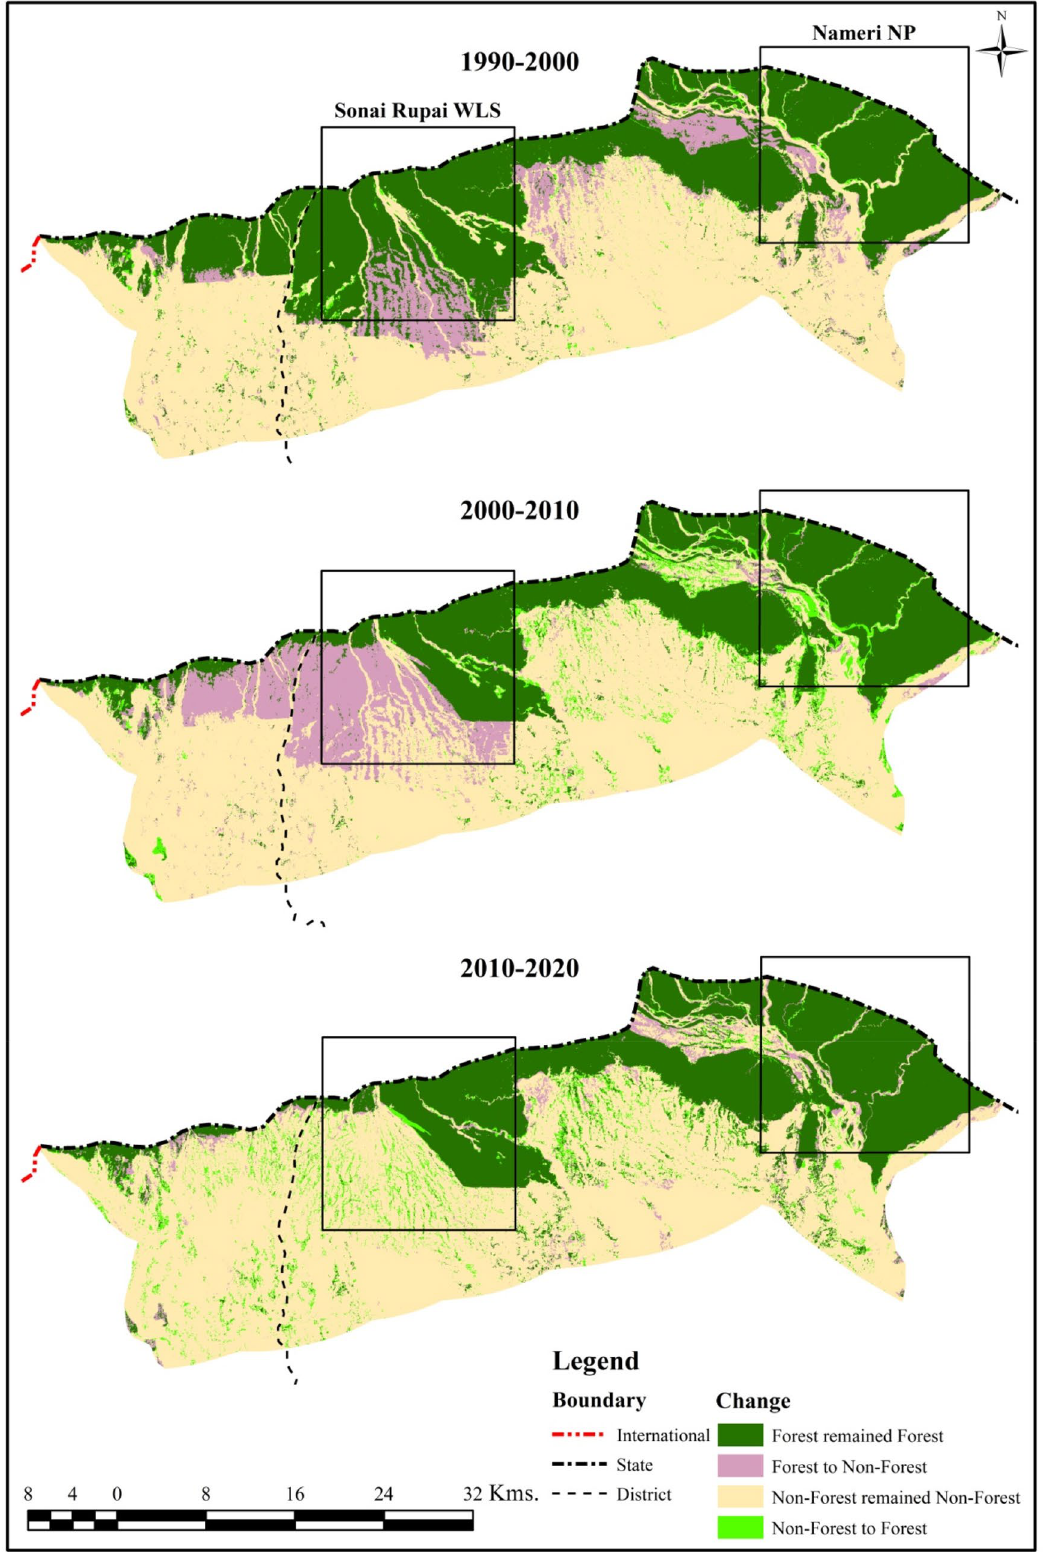
Figure 4. Transition in forest cover (Generated by the authors using ArcGIS 10.3, http:// esri.